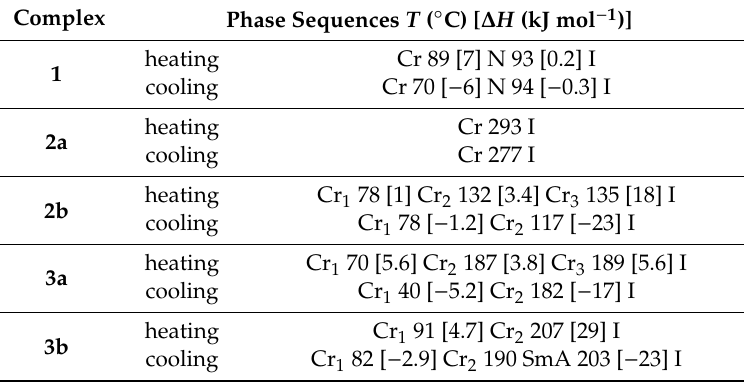
Table 2. Phase transition behavior of Au